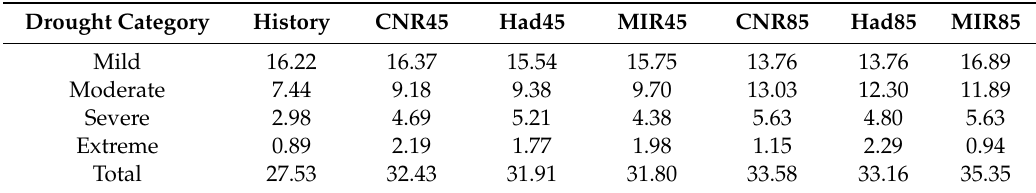
Table 7. Drought frequency (%) in di ff erent drought categories in the whole history (1960–2015)